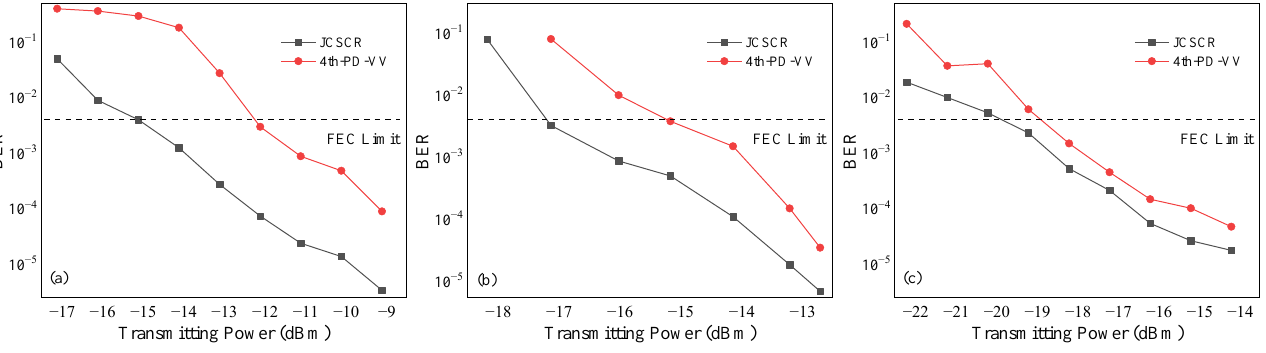
Figure 12. Experimentally measured BER as a function of transmitting power for the proposed algorithm and the 4th-PD-VV algorithm: ( a ) 6.5 × 10 − 14 m − 2/3 , ( b ) 5 × 10 − 15 m − 2/3 , and ( c ) 6 × 10 − 16 m − 2/3